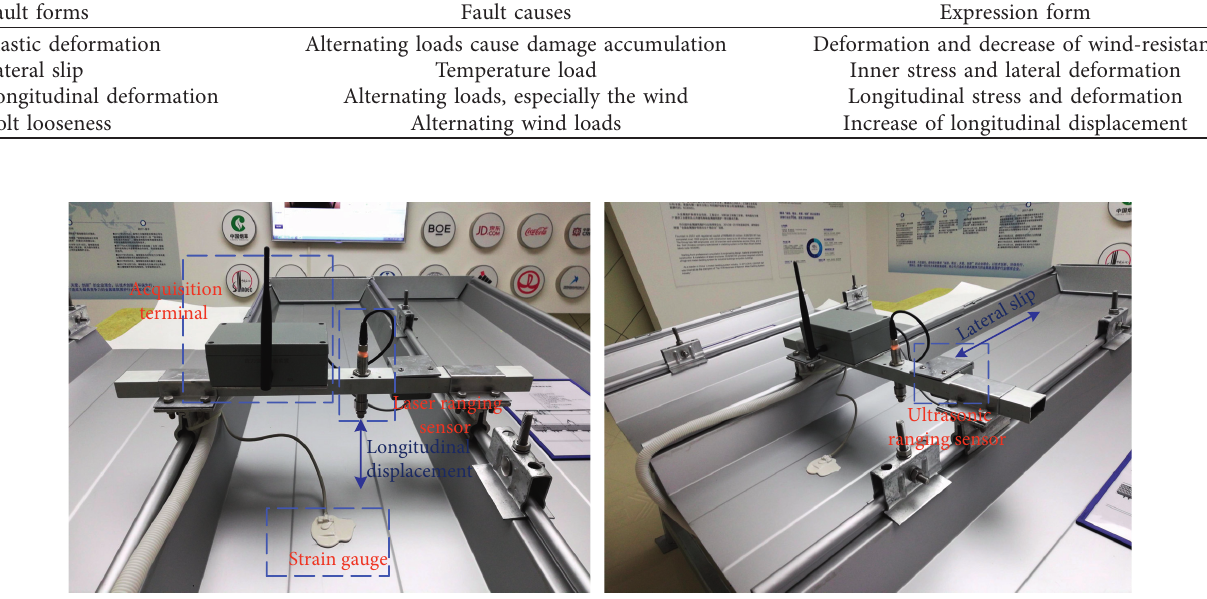
Figure 4: Terminal node sensor layout. Table 2: Type and function of the sensor.